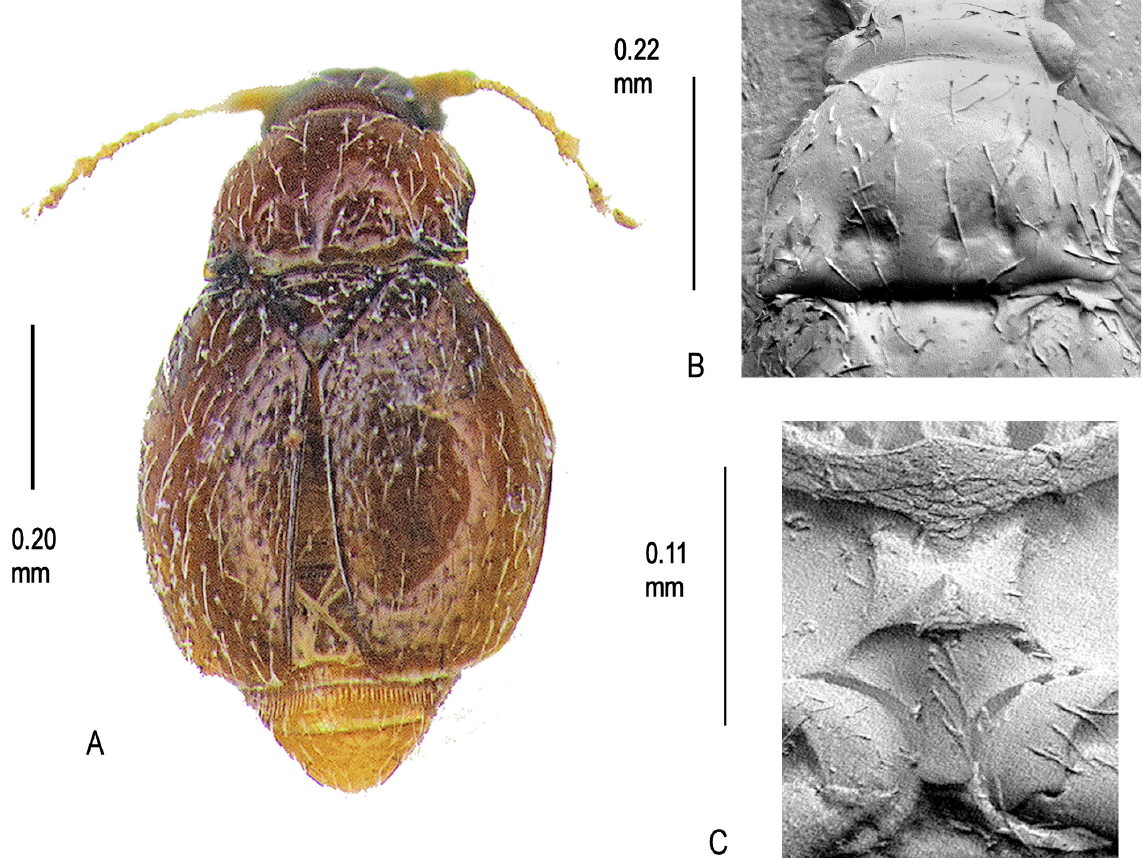
Fig. 44 . Cissidium subfoveolatum Darby, 2019. A . Habitus. B . Pronotum, × 485. C . Mesoventrite showing median process of collar, mid-keel and keel, ×